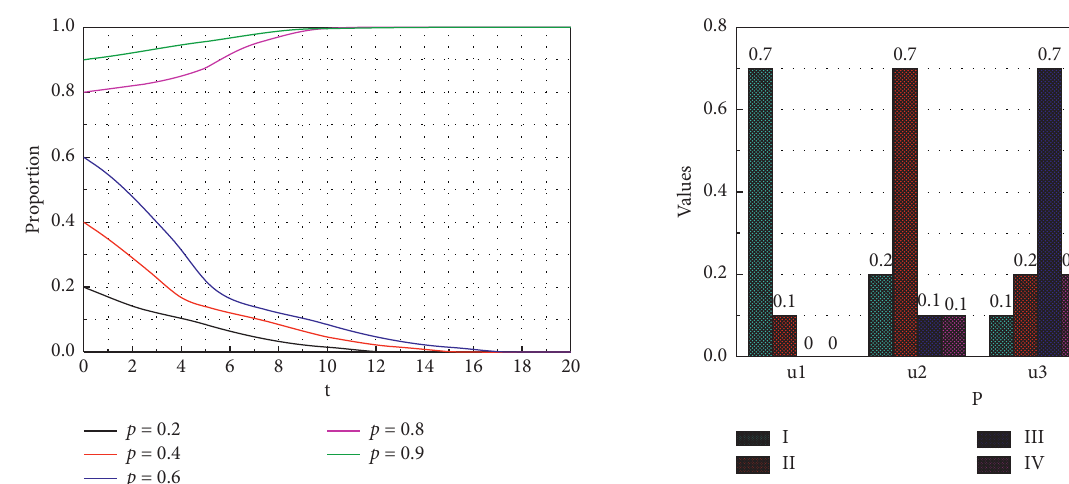
Figure 6: The value of conditional probability P ( ij ) in the first stage.